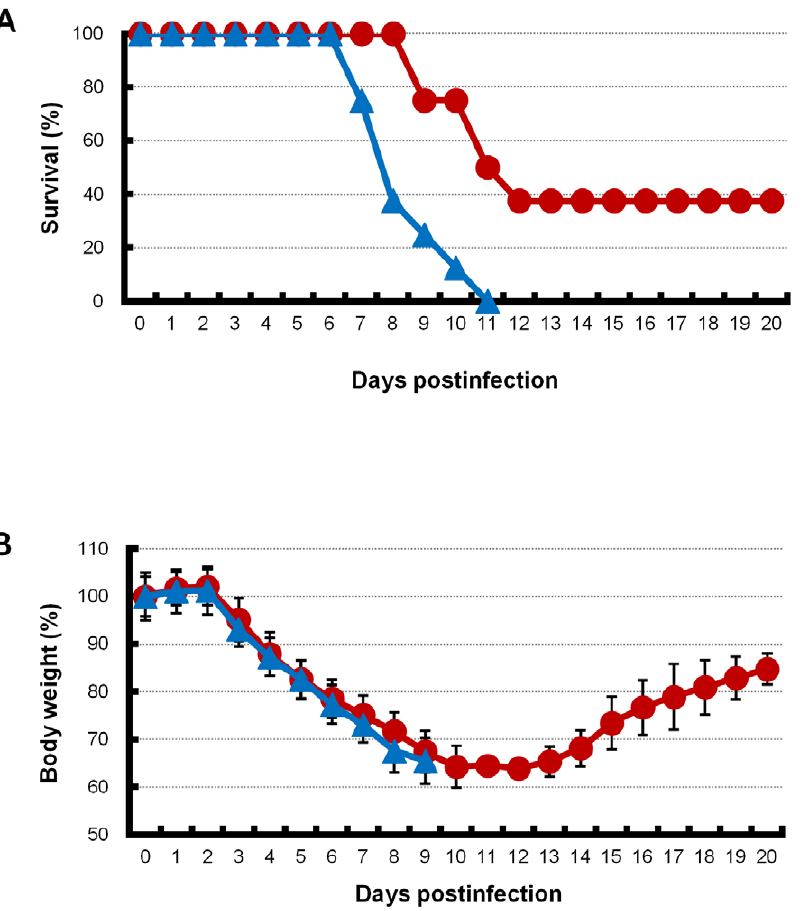
Figure 2. Survival curves and body weights of infected mice with combination therapy or monotherapy. (A) Survival curves of infected mice with combination therapy of artificial surfactant with laninamivir octanoate are shown. Mice infected with an extremely high dose (3741 MLD 50 ) of PR8 virus were treated with laninamivir octanoate. The mice were additionally administered artificial surfactant (combination therapy, red line) or normal saline solution (monotherapy, blue line) intranasally once daily during 3–14 days postinfection. Significant differences in mouse survival rates between the combination therapy and monotherapy groups were analyzed by the log-rank original method. Experiments were independently repeated three times. Percentage survival in a representative experiment is shown. (B) Mouse body weight of the combination therapy (red line) and monotherapy (blue line) groups is shown. Experiments were independently repeated three times. The percentage of mouse body weight in a representative experiment is shown. Differences in means 6 SD are shown.